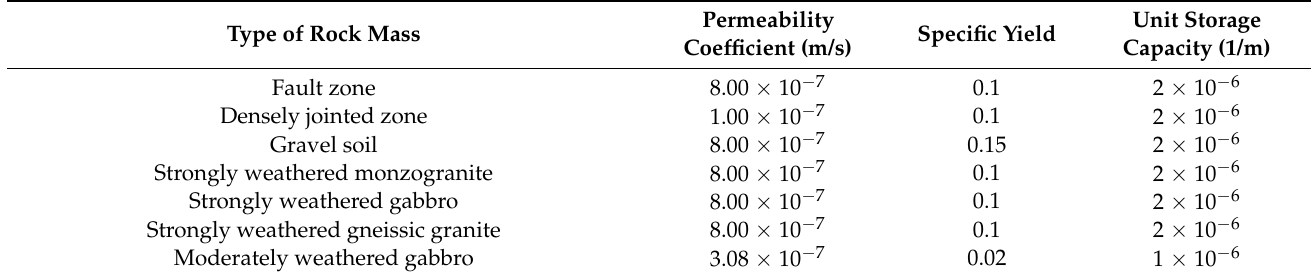
Table 1. Material parameters for seepage field